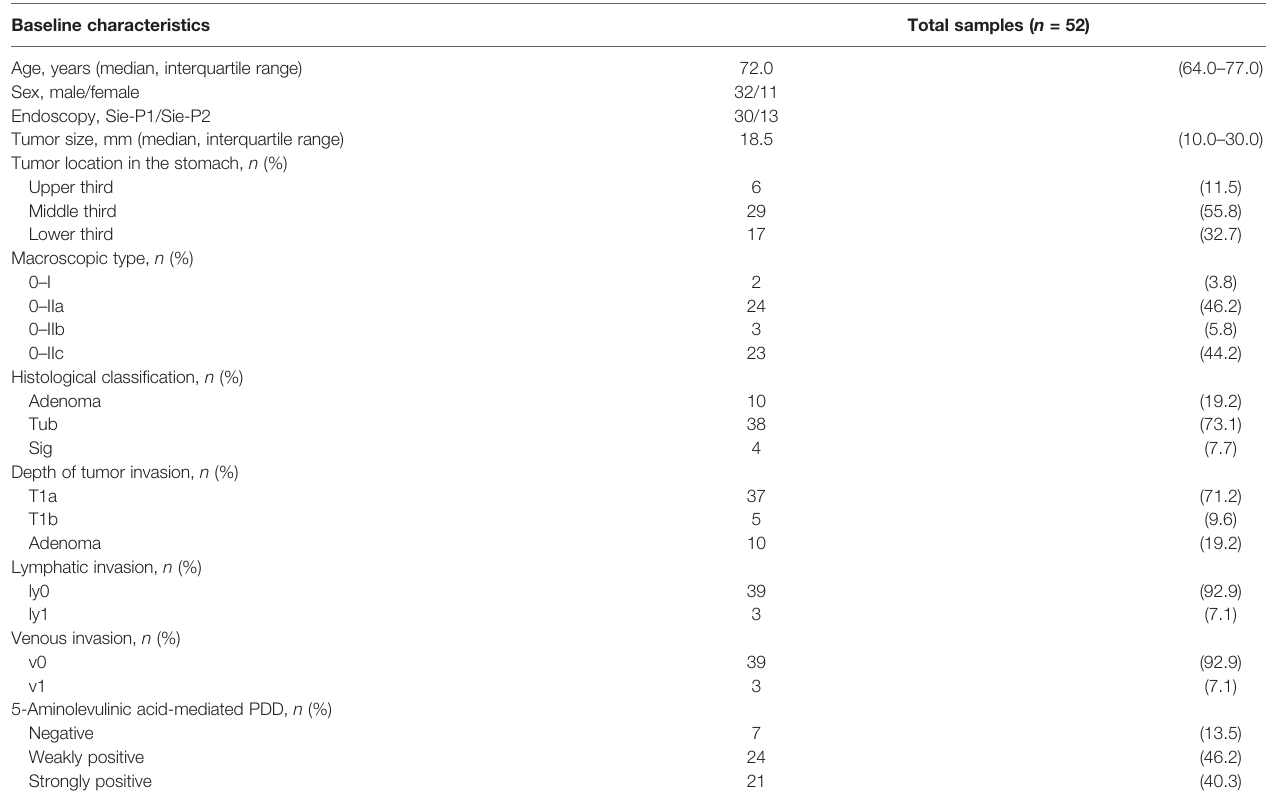
TABLE 1 | Characteristics of 52 lesions in 43 patients with early gastric cancer and/or adenoma who underwent endoscopic photodynamic diagnosis (PDD). Baseline